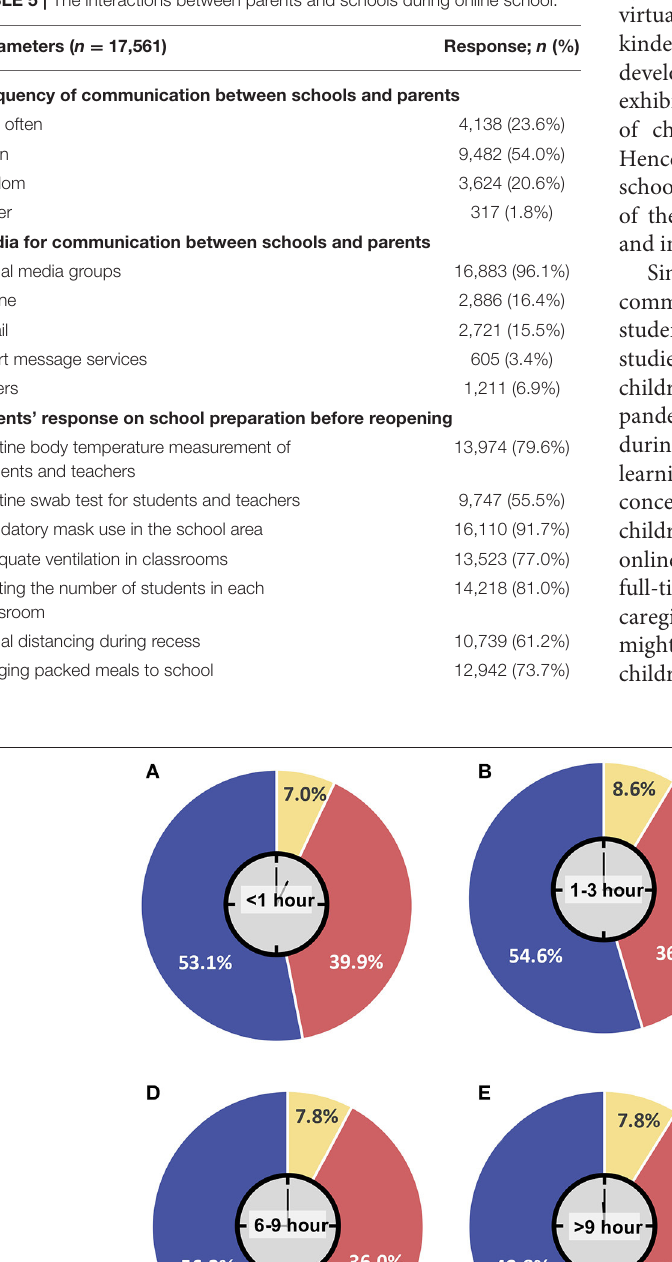
TABLE 5 | The interactions between parents and schools during online school.